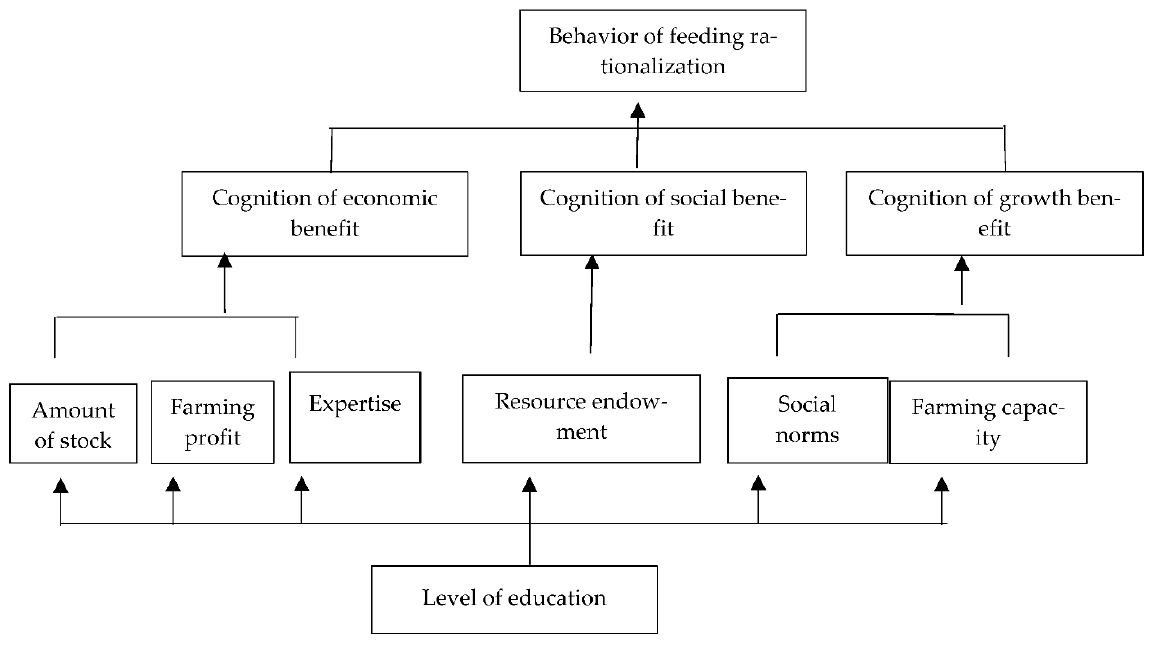
Figure 3. Correlation and Hierarchical Structure Among Influencing Factors of Feeding Rationalization.